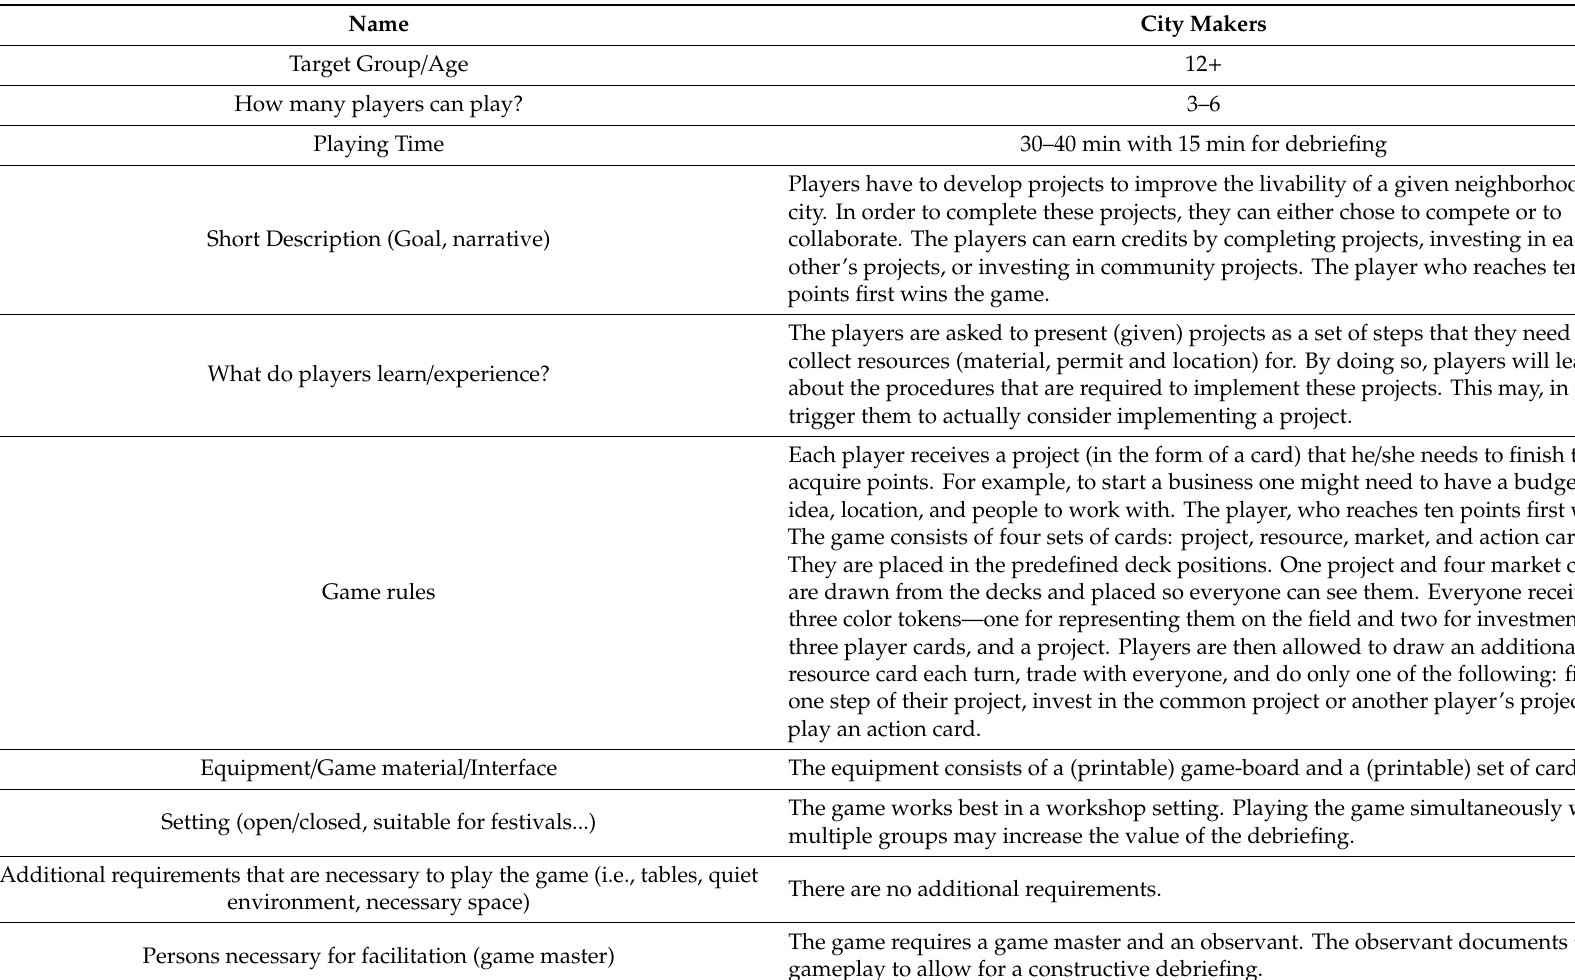
Table 4. City Makers—game